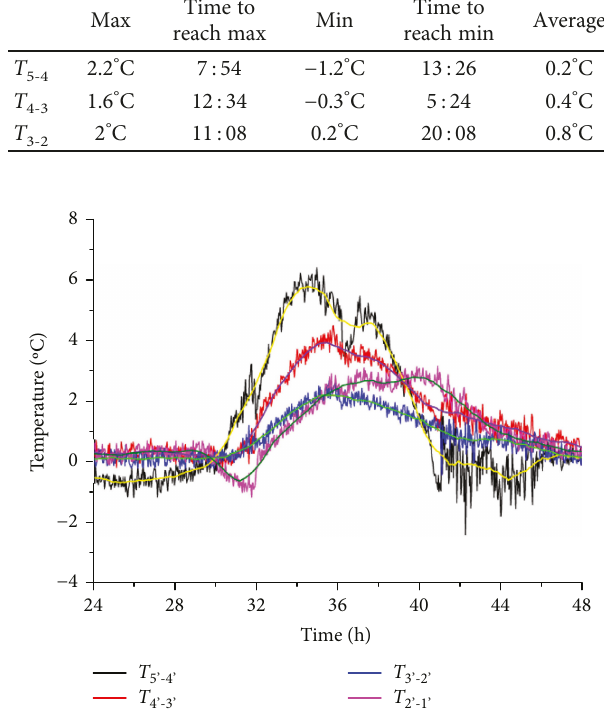
Figure 7: Temperature di ff erence between the nodes of the interior air channel.